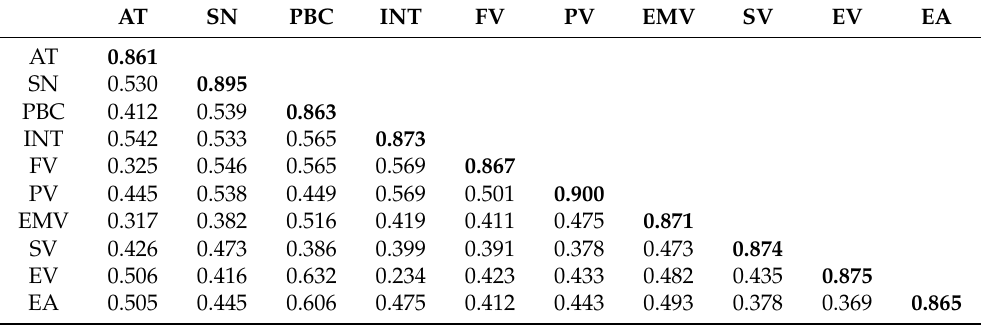
Table 4. Square roots of the AVE and constructor correlation